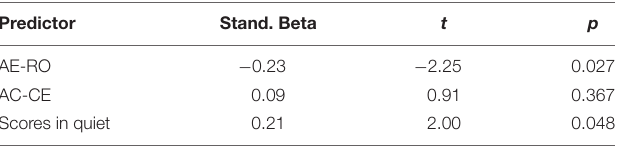
TABLE 6 | Beta-weights of AE-RO, AC-CE and comprehension scores in quiet as the predictors of English listening comprehension in Chinese babble. Predictor Stand. Beta